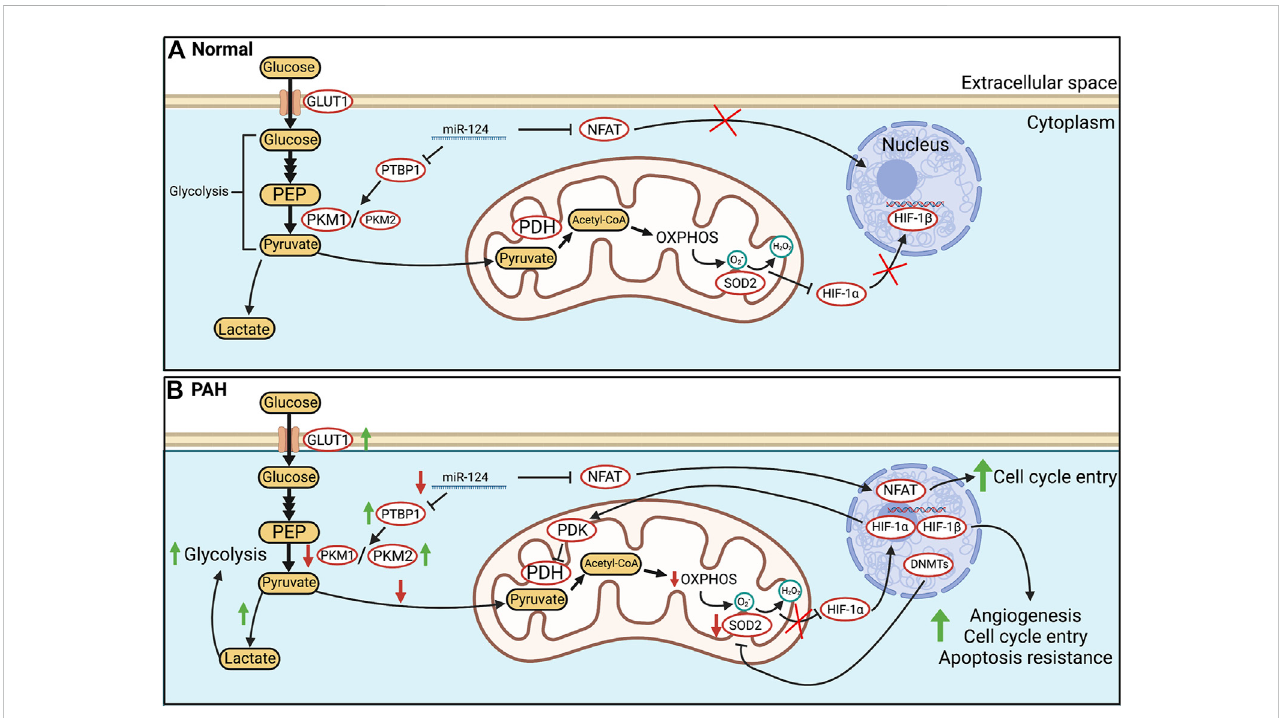
FIGURE 1 GlucosemetabolisminhealthandPAH. (A) .InhealthyPASMC,glycolytically-sourcedpyruvateistransportedtomitochondriaandconvertedintoacetyl- CoA for use in oxidative phosphorylation (OXPHOS). In normoxic PASMC, HIF-1 α is inactivated via a basal production of mitochondria-derived H 2 O 2 . (B) . In human PAH and experimental PH, there is an epigenetic suppression of SOD2 and a related decrease in H 2 O 2 production which activates HIF-1 α , despite normoxic conditions. Transcriptional activation (activation of NFAT and HIF-1 α ) and epigenetic alterations (decreases in miR-124, and activation of DNA methyltransferases) occur in PAH PASMC. Decreases in miR-124 levels increase transcription of PTBP1 which increases the PKM2/PKM1 ratio, favouring glycolysis. In addition, HIF-1 α increases the transcription of PDK which inhibits PDH. The net effects are enhanced uncoupled glycolysis and suppressed OXPHOS. These metabolic changes induce a proliferative, apoptosis-resistant state which, because of similarities to the PASMC ’ s phenotype upon exposure to environmental hypoxia, we refer to as a “ pseudohypoxic state ” . Abbreviations: DNMTs — DNA methyltransferases; GLUT1 — Glucose transporter 1; HIF-1 α / β — Hypoxia-inducible factor 1 α / β ; PDH — Pyruvate dehydrogenase; OXPHOS — Oxidative phosphorylation; NFAT — Nuclear factor of activated T